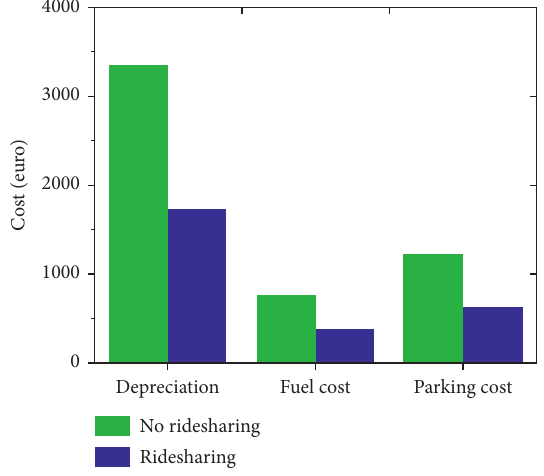
Figure 12: Cost comparison between ridesharing and no